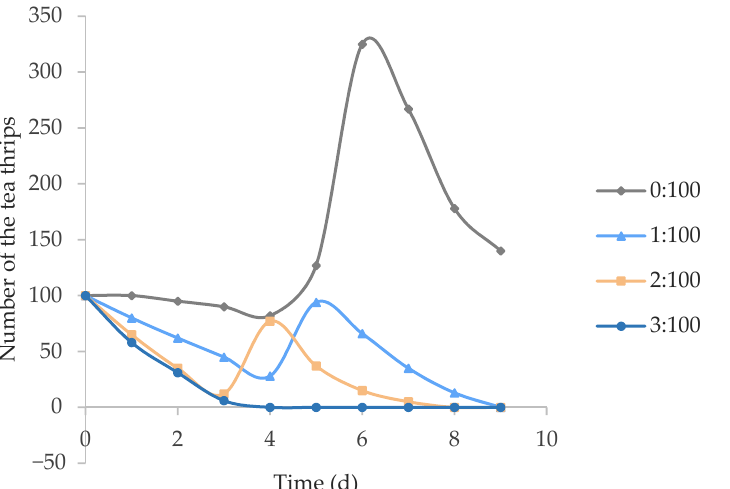
Figure 5. Changes in population of tea thrips under different benefit/harm ratios (number of O. sauteri /number of tea thrips).